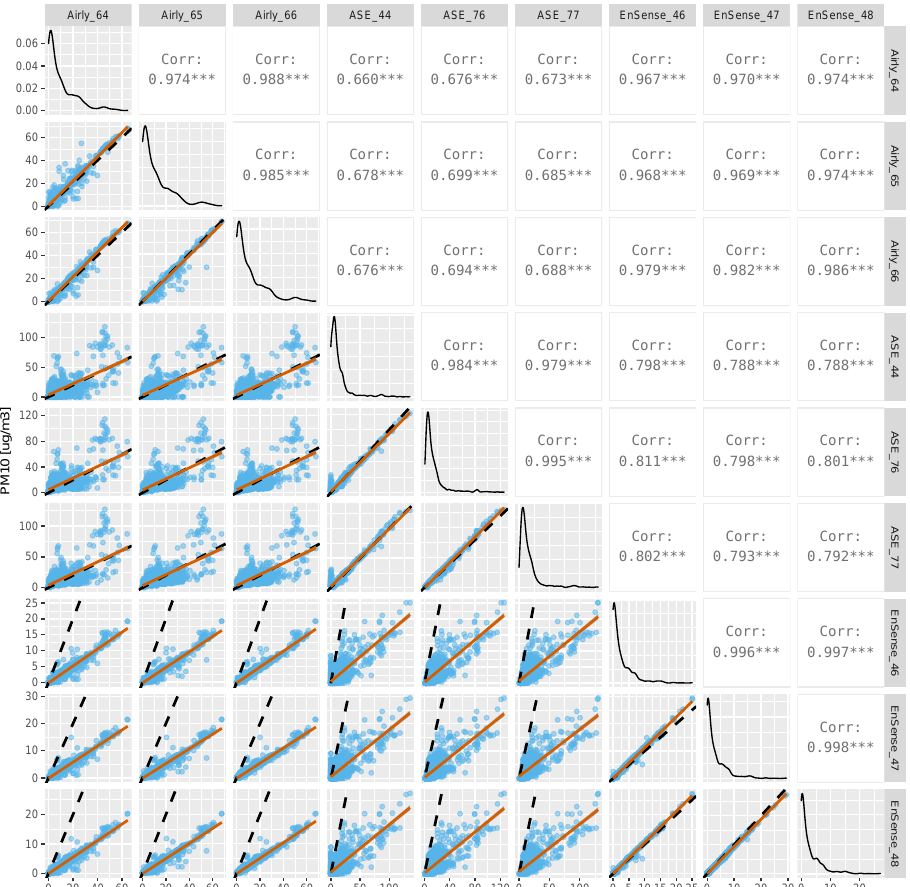
Figure 6. Sensor-to-sensor intercomparison of the factory-calibrated PM 10 signal of all sensors systems against each other during the co-location period. Axes labels are shown here in units of µg m − 3 . The lower left panels show scatterplots of one sensor’s output against the other (with the black dashed line indicating the 1:1 reference line and the red line a linear regression fit to the data). The panels on the diagonal show the probability density function of the readings of each individual sensors. The panels on the upper right show the Pearson correlation of the scatterplots on the lower left. *** means the correlation is